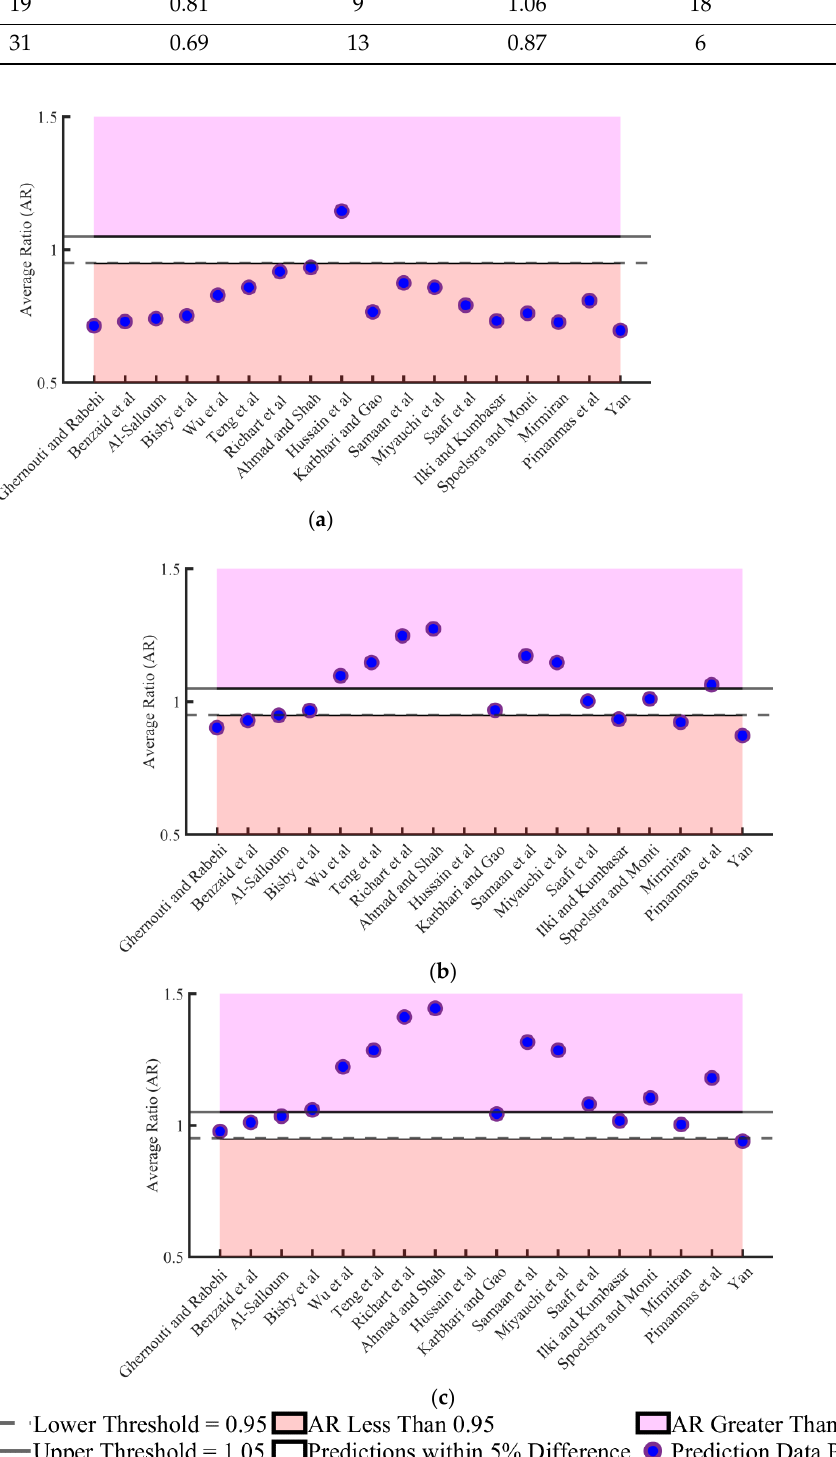
Figure 15. Average ratios of analytical models for ( a ) Group 1 ( b ) Group 2, and ( c ) Group 3 [33 – 50].